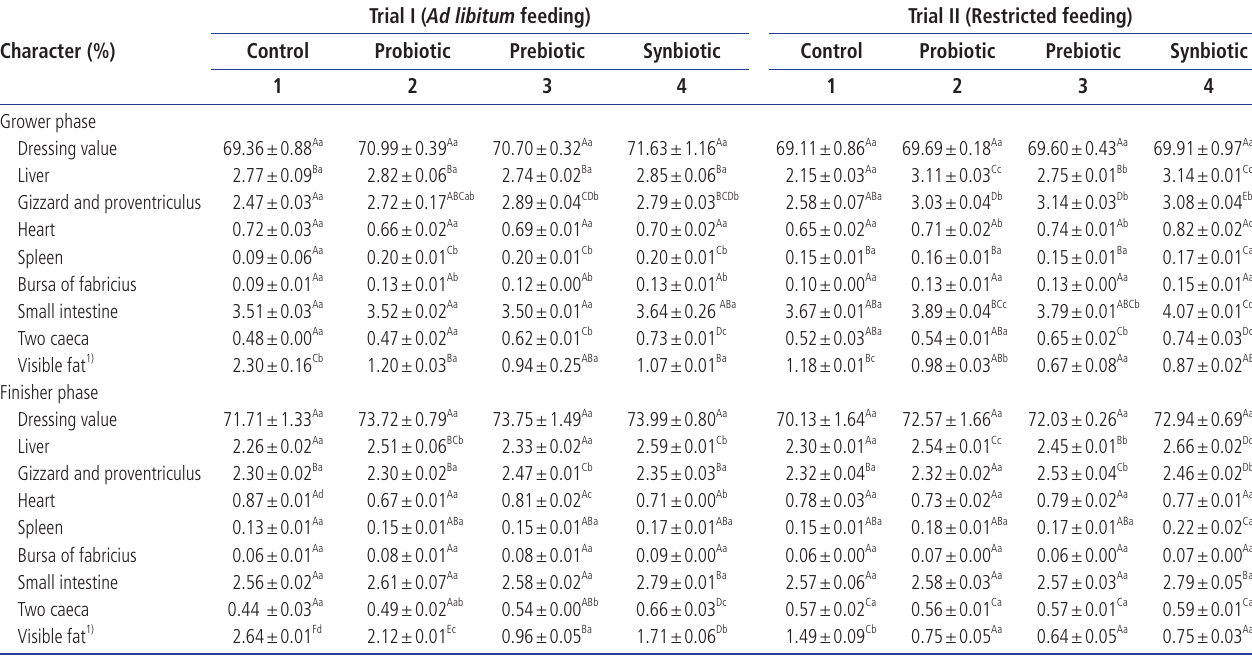
Table 5. Relative carcass and organ weights (% of body weight) of the different experimental groups at the end of the grower and finisher periods (Mean±SEM) Trial I (Ad libitum Character (%)